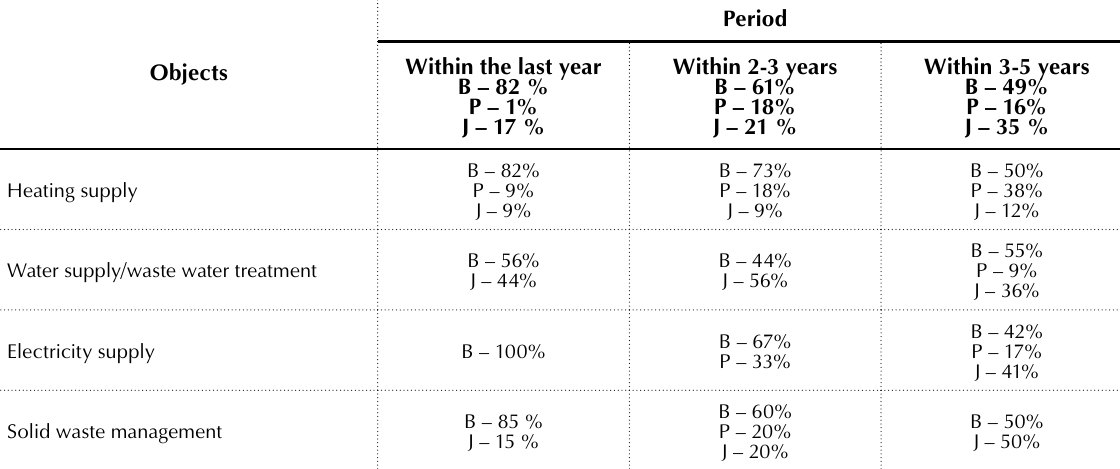
Table 2. The distribution of investments in the objects of municipal infrastructure of the Tver region